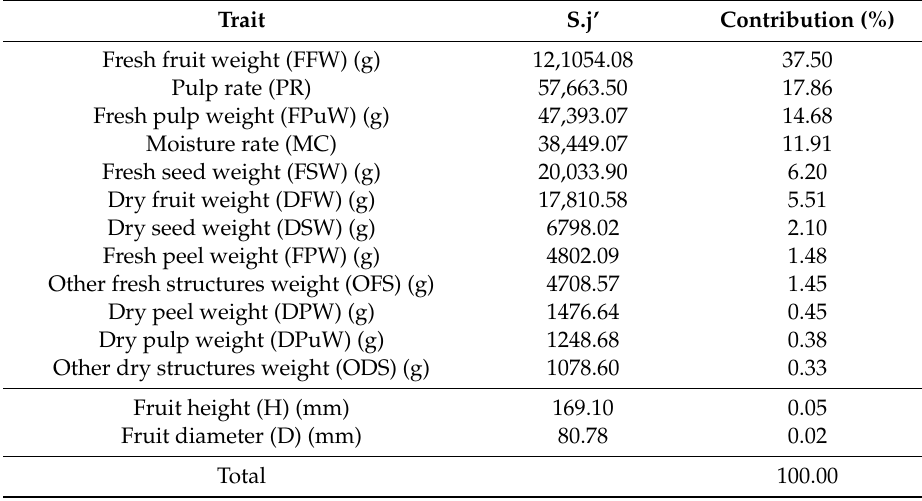
Table 2. Relative dissimilarity (S.j’) contribution rate of the 14 quantitative traits analyzed in the fruits and seeds.